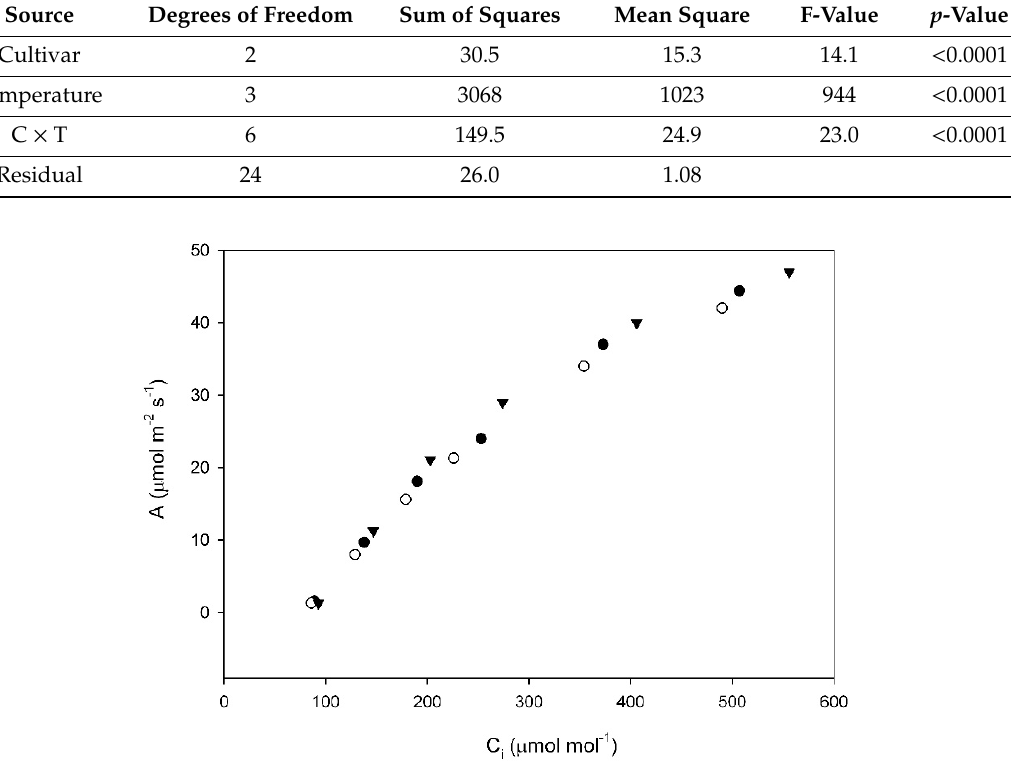
Figure A1. Examples of A vs. C i curves. These curves are for three leaves of Spencer grown at 25 °C, and measured at 30 °C. Different symbols represent different leaves. Some data points have been omitted for clarity.